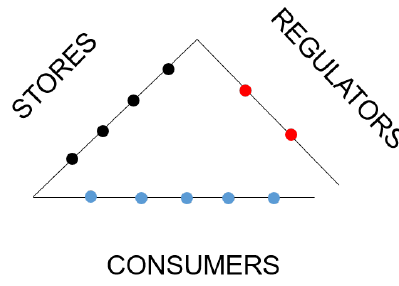
Figure 1. Conceptualization of Interacting Entities using Routine Activity Theory